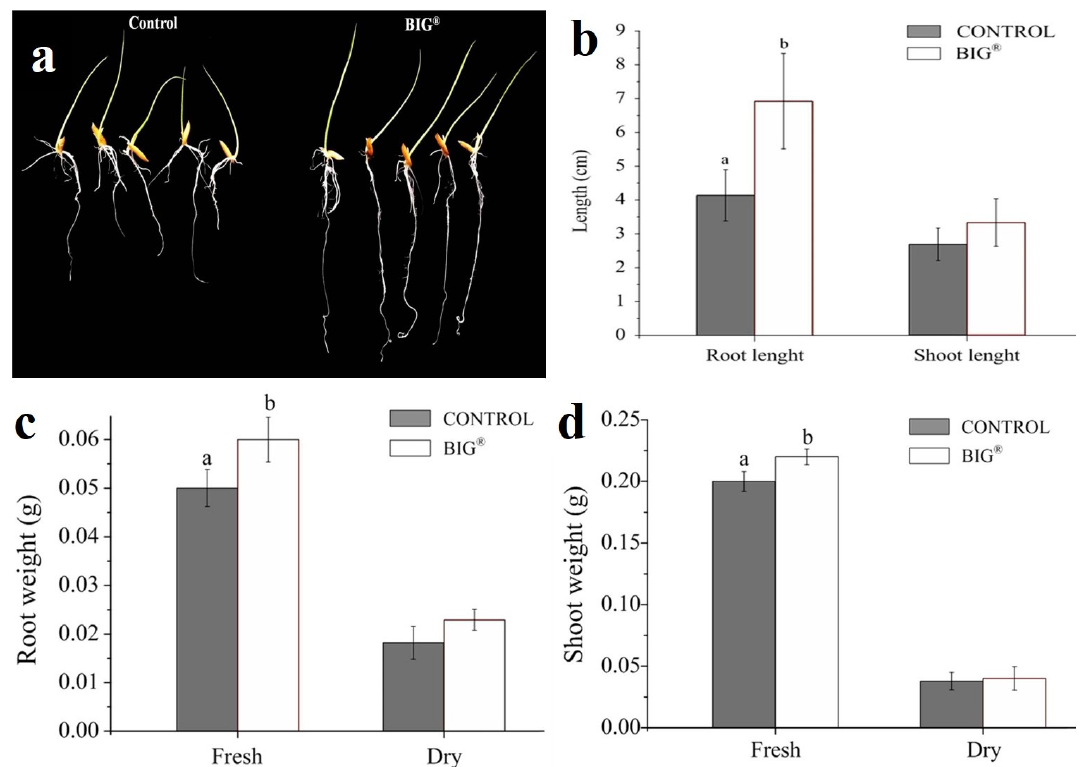
Figure 2. Effect of the natural plant elicitor BIG ® on rice growth on a sterile agar medium. ( a ) Quantification of root length and shoot length. ( b ) Root fresh weight and dry weight, ( c ) shoot fresh weight, and ( d ) dry weight after 7 days of cultivation.